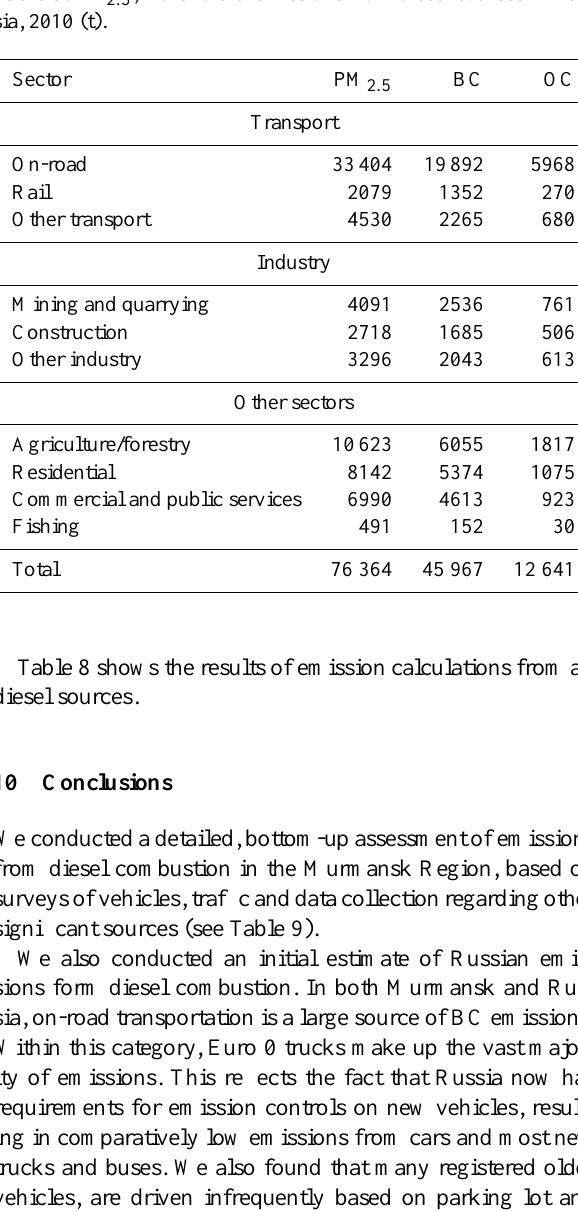
Table 8. PM 2 . 5 , BC and OC emissions from diesel sources in Rus- sia, 2010 (t).